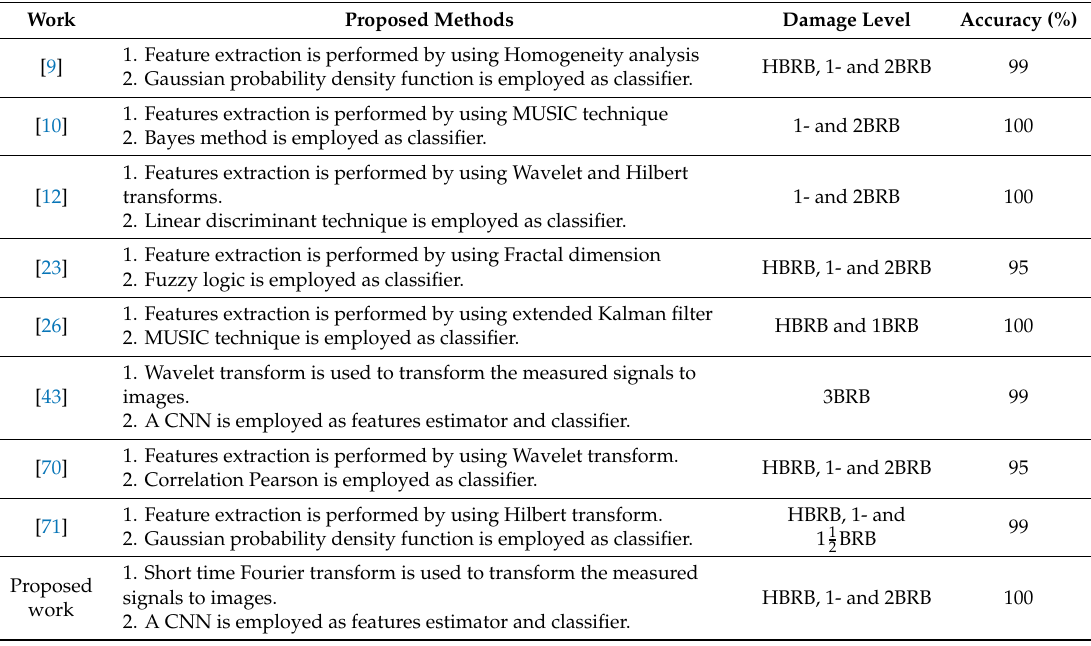
Table 3. Results and characteristics o ff ered by the proposed work and previous